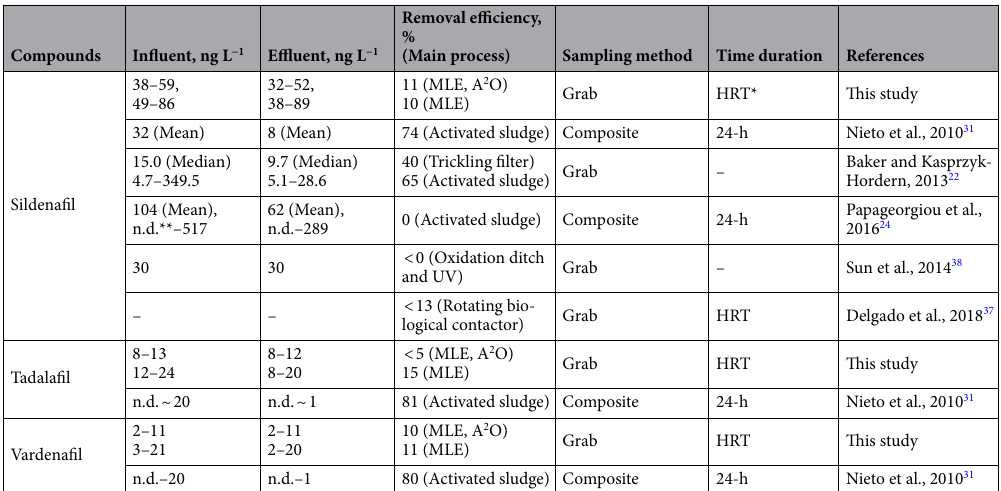
Table 3. Occurrences and removal efficiencies of PDE-5i by STPs reported by this study and the literatures. *HRT: Sampling interval between influent and effluent considered by hydraulic retention time. **n.d.: not